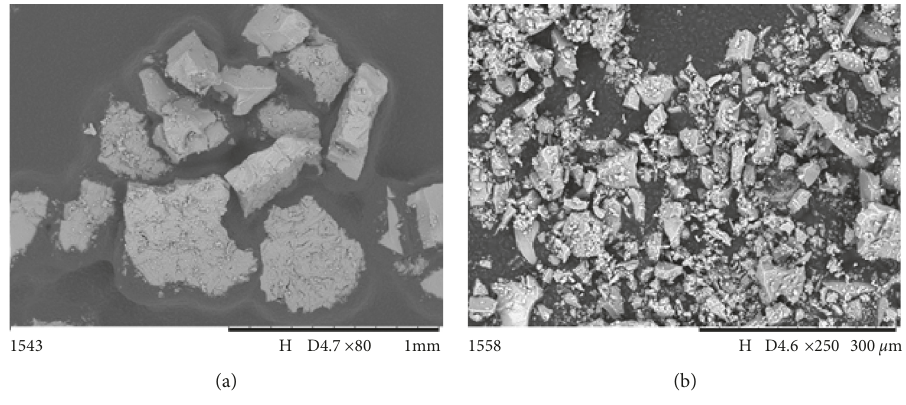
Figure 17: CaF 2 particles after precipitation in the Kenics static mixer: (a) Re